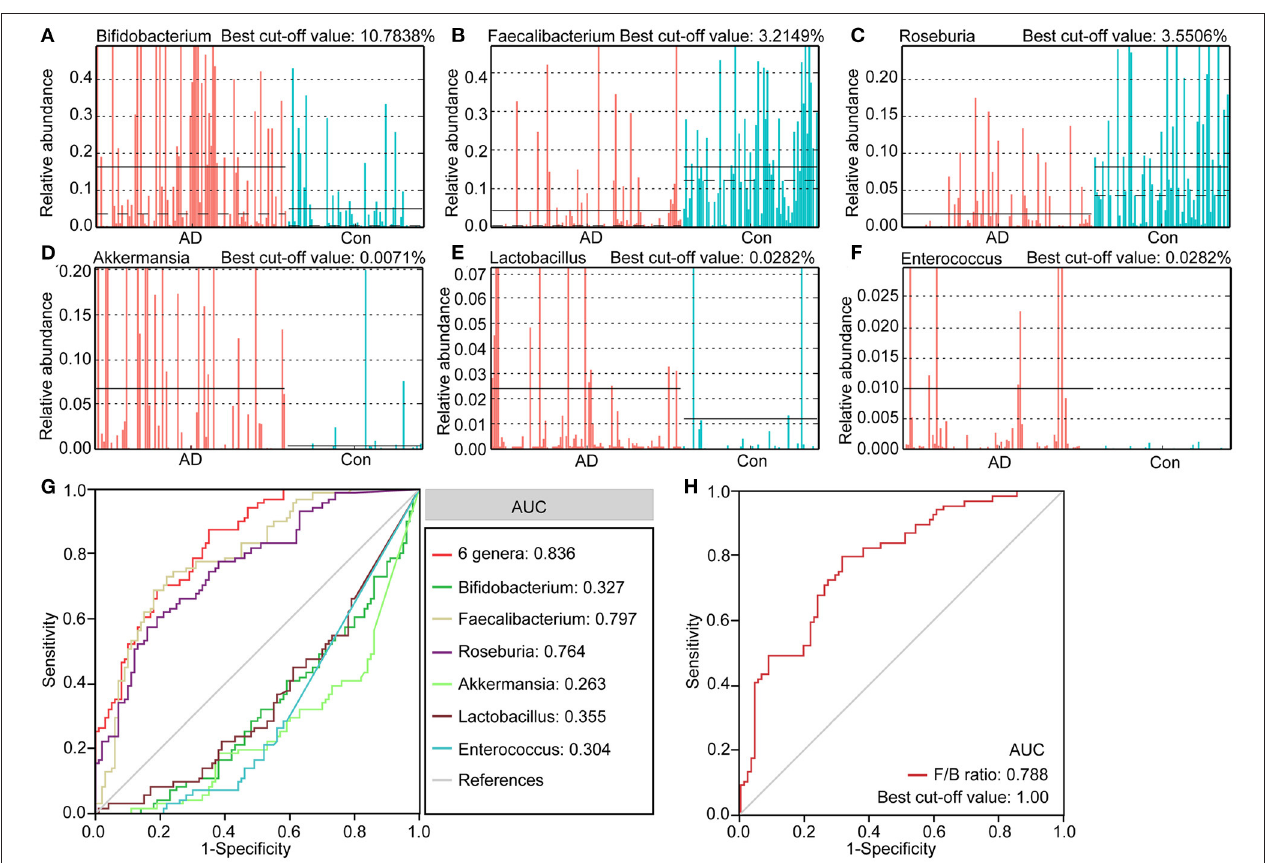
FIGURE 4 | The differential genera as AD diagnostic markers. The relative abundance and best cut-off values of the differential genera such as Bifidobacterium (A) , Faecalibacterium (B) , Roseburia (C) , Akkermansia (D) , Lactobacillus (E) , Enterococcus (F) in each sample. Receiver operating characteristic (ROC) curves for the differential genera alone or in combination (G) , and Faecalibacterium/Bifidobacterium (H) , used to discriminate healthy controls from AD patients. AUC, the area under the receiver operating characteristic